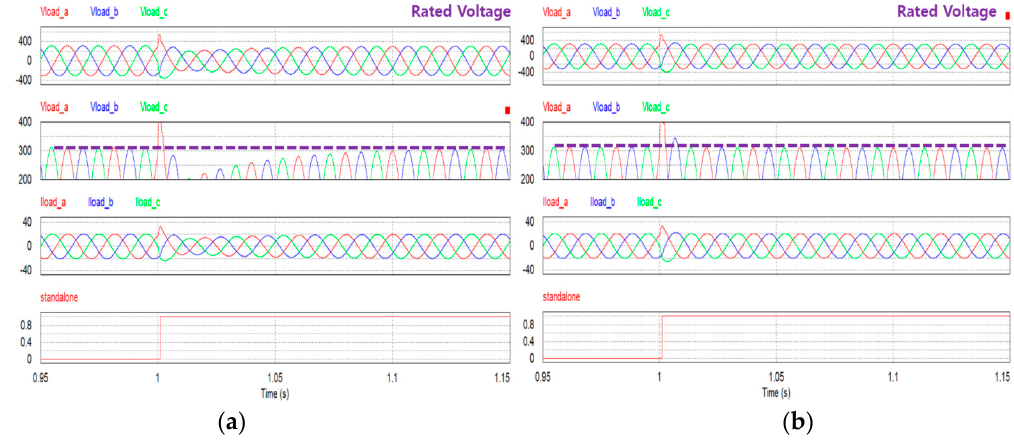
Figure 17. Simulation results of mode switching in case of a load change in a weak-grid condition: ( a ) using the general inverter controller; ( b ) using the proposed load current compensation controller.